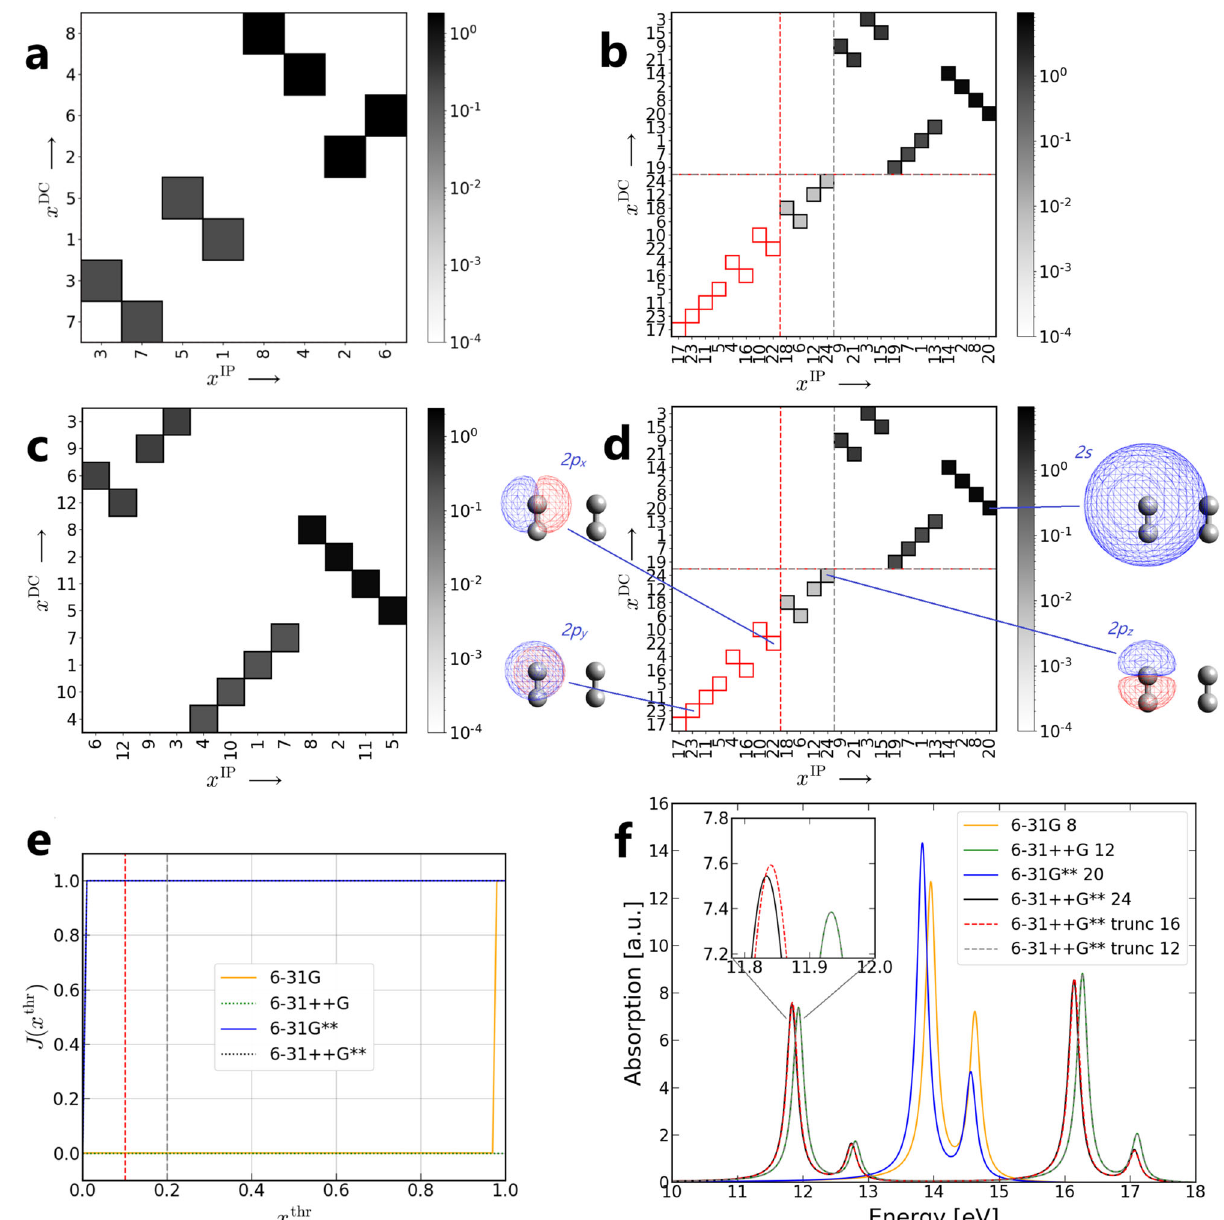
Fig. 2 | RT-TDHF calculations of the H 2 dimer. x DC - x IP map obtained with a 6-31G, b 6-31G**, c 6-31++G,and d 6-31++G**basisset.Eachsquareinthemaprepresentsa basisfunctionwithitsnumberingon x and y axes.Thecolorofthesquaresisbased on the value calculated as x DC ⋅ x IP , so the deeper the color the more important the basis function is in the TDHF calculation. d includes the visualization of related basis functions. Axis labels (basis functions) are sorted in ascending order according to their x DC or x IP values. The red dashed line represents x thr =0.1 and the